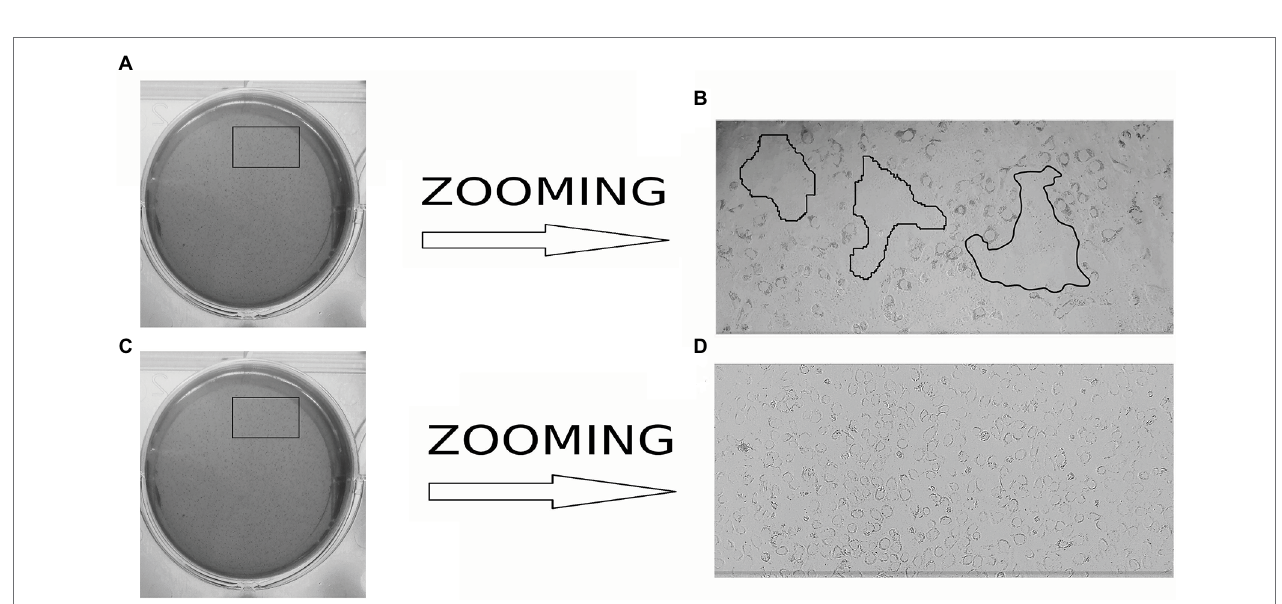
FIGURE 4 | Association with F-actin in Listeria monocytogenes -infected shKEC cells. (A) shKEC cells infected with L. monocytogenes . The white arrows point to a cytoskeletal rearrangement stained phalloidin. (B) shKEC cells noninfected with L. monocytogenes ; these cells are used as a control. The samples were captured with an Axio Scope A1 fluorescence microscope at 1,000× magnification in 10 independent replications.